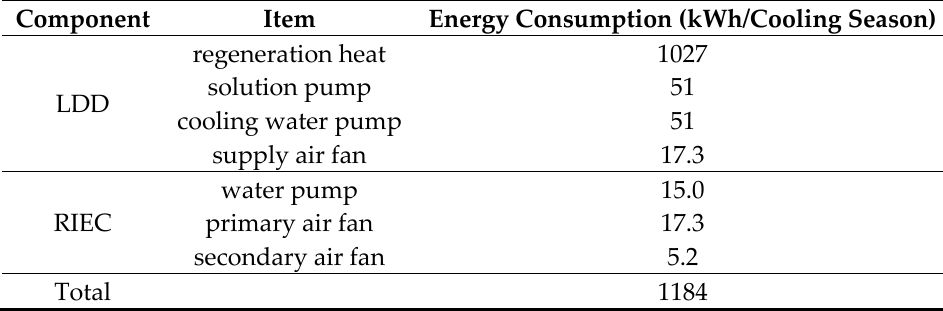
Table 2. Breakdown of energy consumption in LDD-RIEC